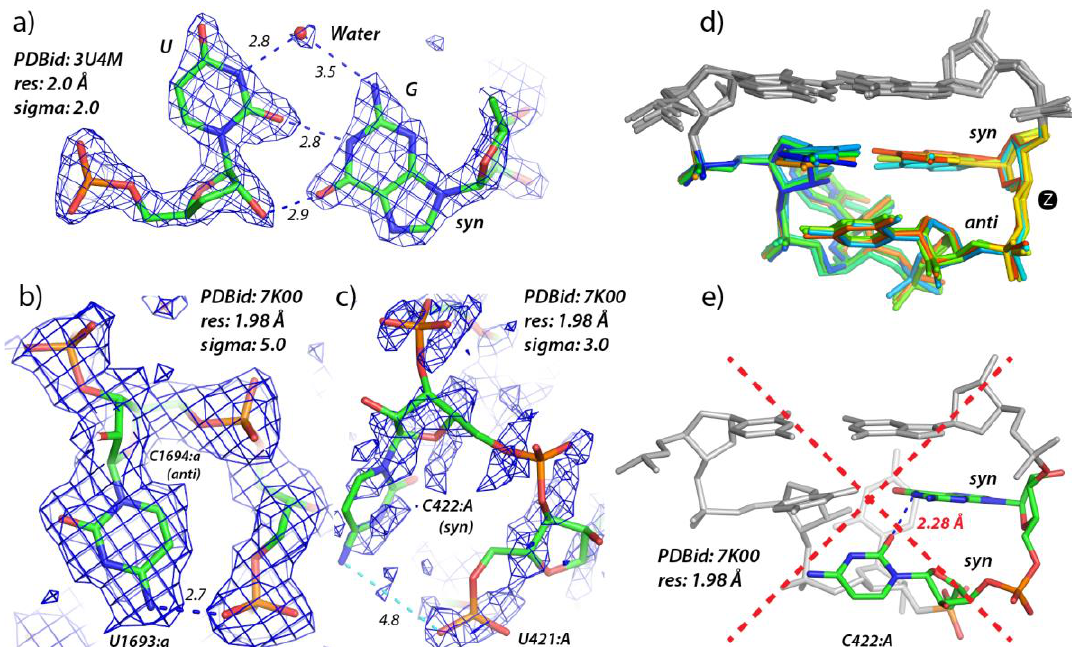
Figure 6. r(UUCG) structural details derived from X-ray and cryo-EM. ( a ) A tSW U 2144:B •G 2147:B pair that is part of an r(UUCG) tetraloop showing a water molecule bridging an amino and an imino Watson-Crick site (PDBid: 3U4M). ( b , c ) Views of the interaction are shown in Figure 1d for two tetraloops extracted from the 7K00 cryo-EM structure. In ( c ), the density is poor at a 3.0 sigma level and the C422:A residue has been modelled in syn leading to a loss of an important interaction shown in ( b ) where the density at a higher 5.0 sigma level is unambiguous. Note that X-ray and cryo-EM density sigma levels are not equivalent. ( d ) Backbone superimposition of the five high-quality 5Y85, 3U4M, 7KKV, 4ARC, and 7K00 r(U 1692:a UCG) Z-turns mentioned in the text. The superimposition was made by using Chimera [73]. ( e ) View of the 7K00 r(U 420:A UCG) tetraloop with the cytosine in syn and an unrealistic 2.28 Å hydrogen-bond contact [66]. This short contact reveals major modelling issues in regions of a 1.98 Å resolution cryo-EM structure and explains why this tetraloop structure must be discarded.